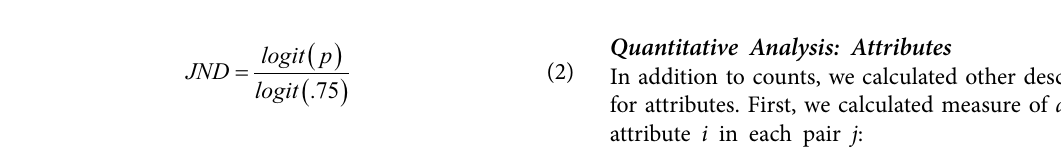
FIGURE 1 | Image contents used in the study. Of 32 contents, 25 were in landscape mode (A) and seven in portrait mode (B) . For certain contents, there were duplicates taken with back and front camera or with different zooming or flash settings. The models gave a written consent for the publication of the